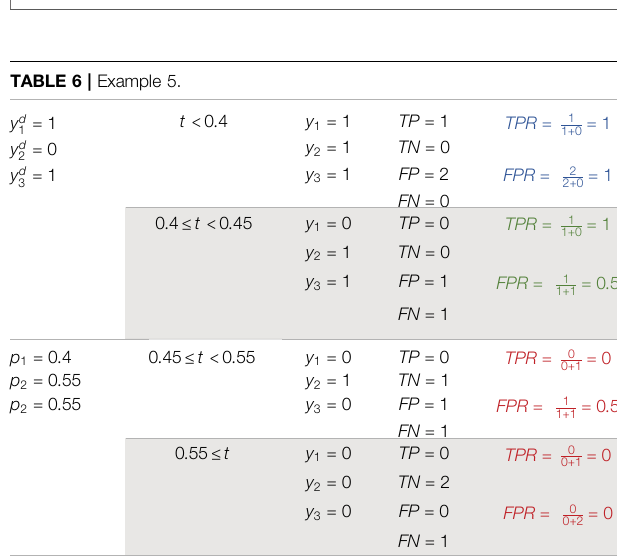
FIGURE 3 | ROC of Example 4.